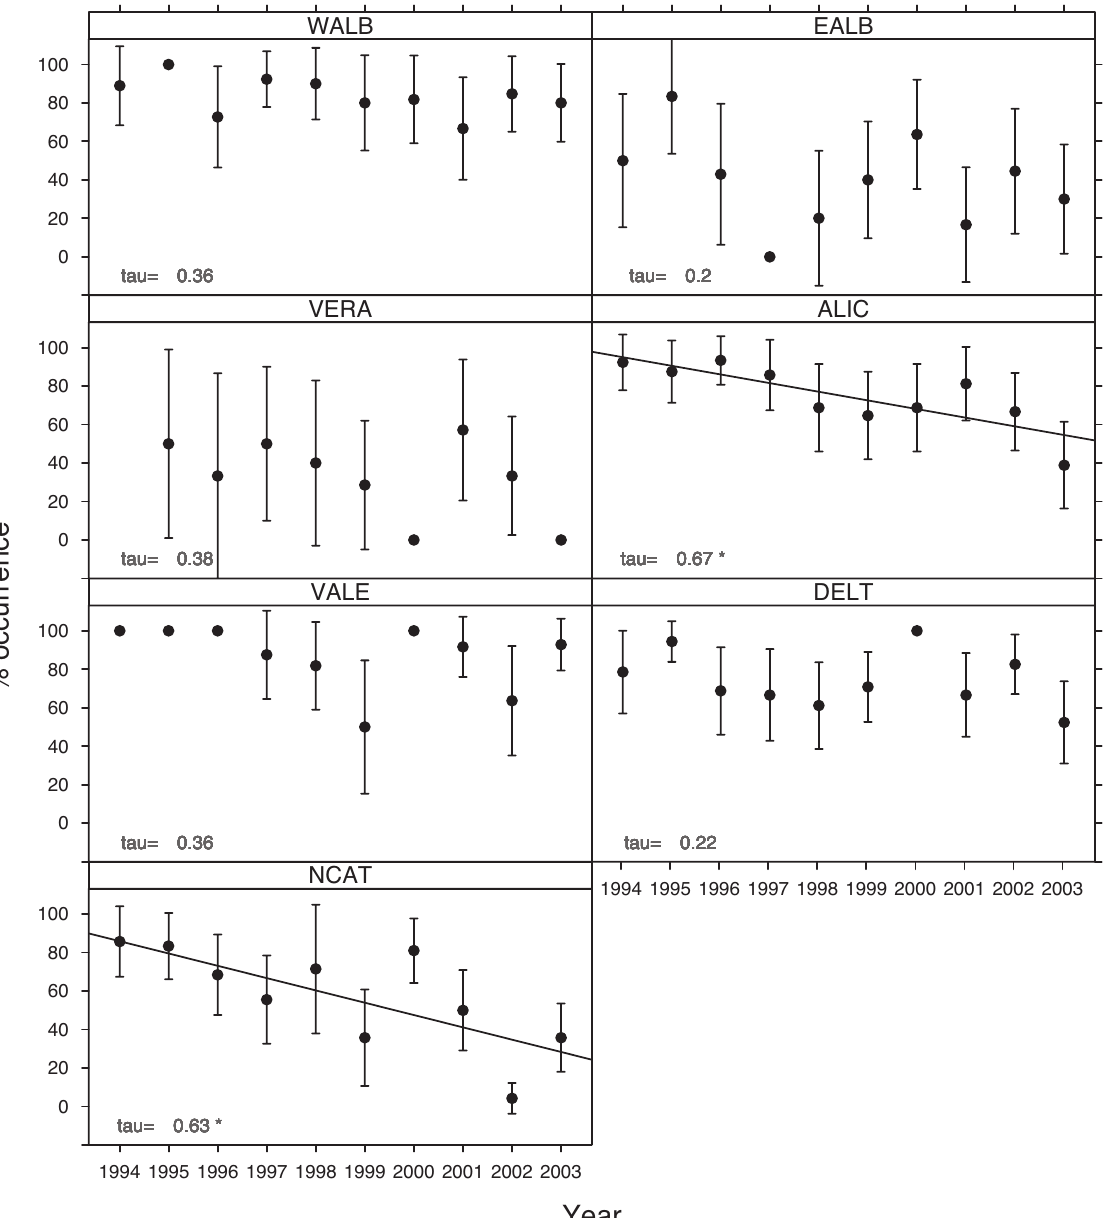
F IG . 5. – Annual and geographic variation of the percentage occurrence (± CI ) of Liocarcinus depurator . The value of Kendal’s T is indi- 95% cated in the bottom left corner of each figure, followed by an * when significant. Lines fitted to significant relationships by least squares regression are merely indicative of the